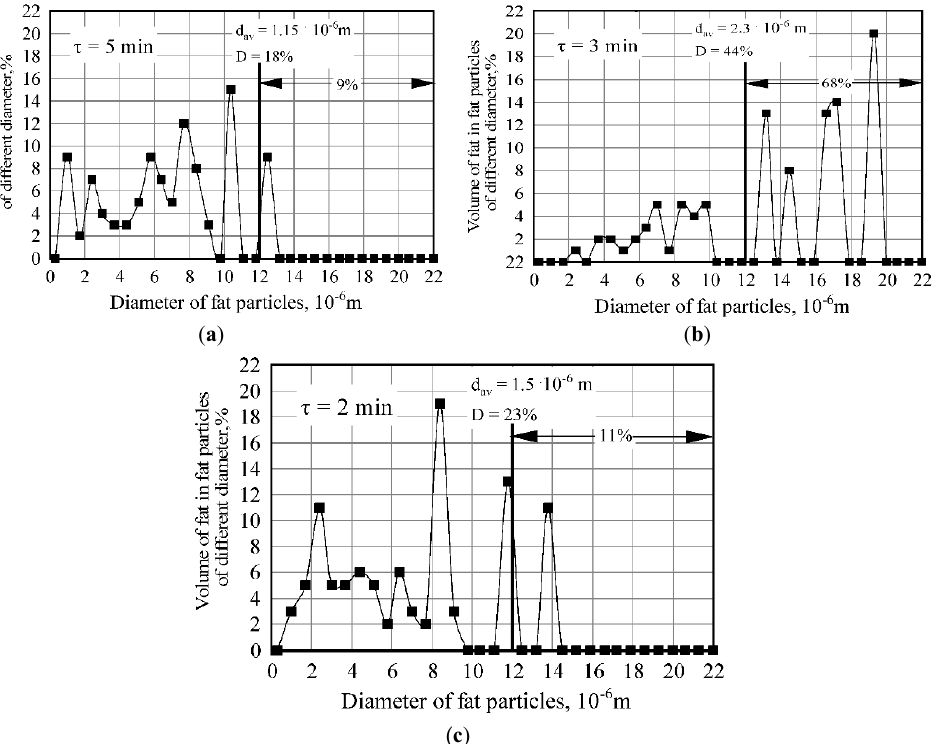
Figure 6. Variance in the granulometric composition of fat emulsion during processing in the emulsification device ( n = 2500 rpm): ( a ) 𝜏 = 5 min; ( b ) 𝜏 = 3 min; ( c ) 𝜏 = 2 min.